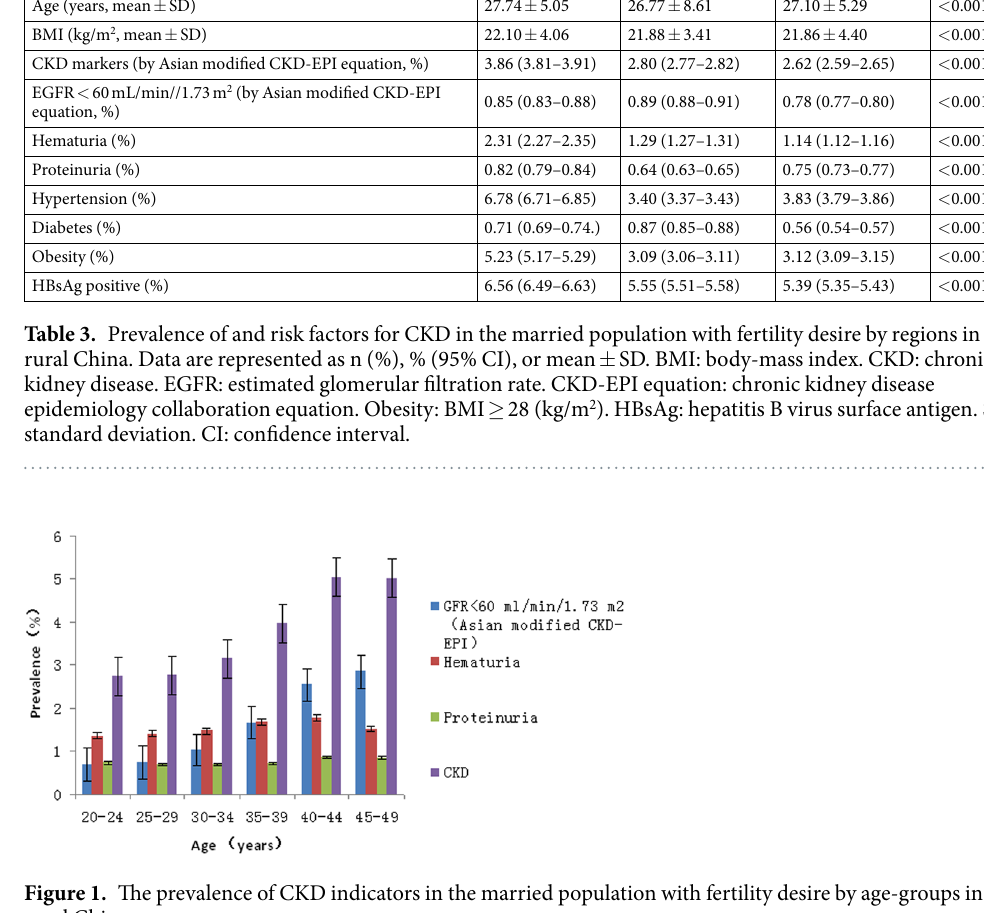
Figure 1. The prevalence of CKD indicators in the married population with fertility desire by age-groups in rural